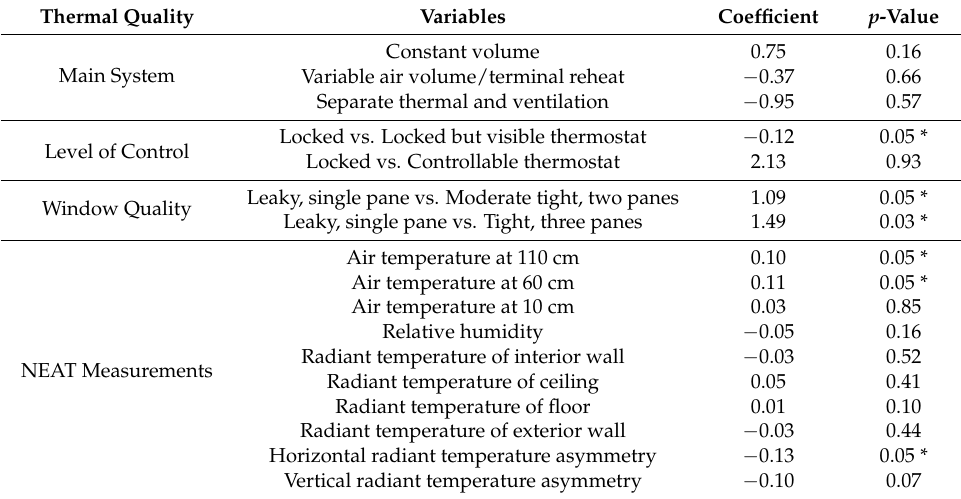
Table 7. Analysis of variance of air temperature at 60 cm from the floor by user satisfaction, cooling season ( n = 309).